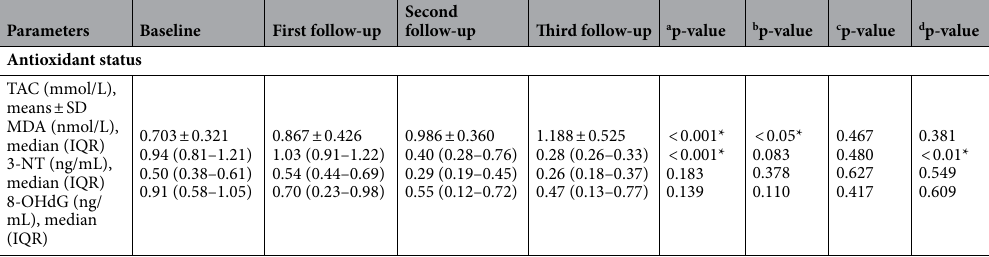
Table 4. Changes in antioxidant status of participant during study as indicated by laboratory outcomes, antioxidant status was analysed from salivary sample. TAC Total Antioxidant Capacity; MDA Malondialdehyde; 3-NT 3-Nitrotyrosine; 8-OHdG 8-hydroxy-2-deoxyguanosine. Statistically significant p values are marked in asterisks (*). a p-value was calculated using general linear model (GLM) for repeated measures model, with sampling time point as within-subjects factor. b p-value was calculated using general linear model (GLM), with gender tested as between-subject effect. c p-value was calculated using general linear model (GLM), with age tested as between-subject effect. b p-value was calculated using general linear model (GLM), with BMI tested as between-subject